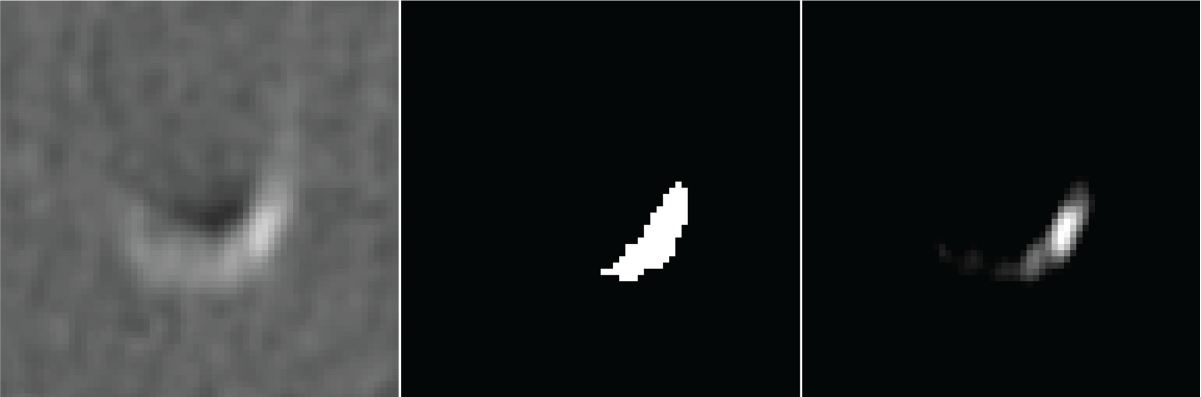
Fig 8. Left: Single CT slice showing the medium sized insert of the SATI phantom with HA density of 400 mg/cm 3 with the simulated motion of 30 mm/s; Middle: Segmentation obtained using C-CS; Right: Segmentation obtained using PVC-CS.